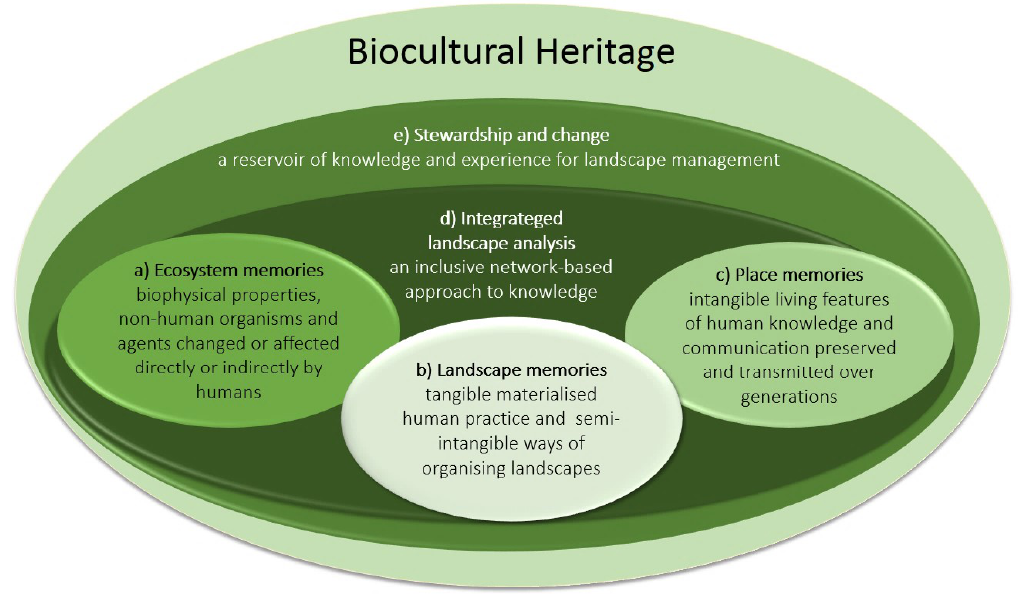
Figure 1. The four ‘elements’ of biocultural heritage ( a – d ) as defined by Lindholm and Ekblom